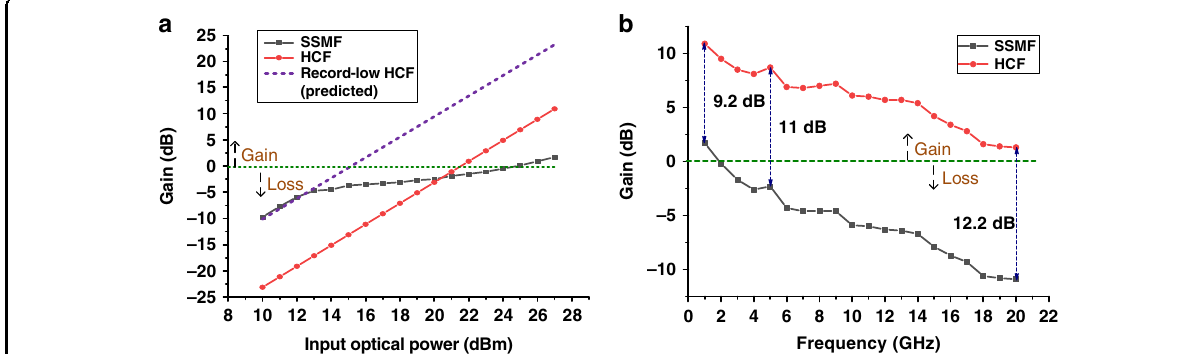
Fig. 4 Measured L-biased APL gain. The set-up is identical to that shown in Fig. 2, other than the MZM is low-biased (L-biased). a Gain is plotted as a function of the optical power launched into the transmission fi bre. The input signal has a frequency of 1 GHz. The measured gain with the SSMF transmission fi bre is shown as a solid line with square symbols) and the measured gain with the HCF transmission fi bre is shown as a solid line with circle symbols. The predicted gain considering a HCF transmission fi bre with the lowest-published attenuation to date is shown as a dashed line. Dashed black arrows indicate net gain or loss. b Measured gain over the frequency range of 0 – 20 GHz obtained for the maximum received power limited by SBS (SSMF APL) and photodiode (HCF APL). The HCF APL shows 9, 11 and 12 dB higher gain than the SSMF APL at frequencies of 1, 5 and 20 GHz,